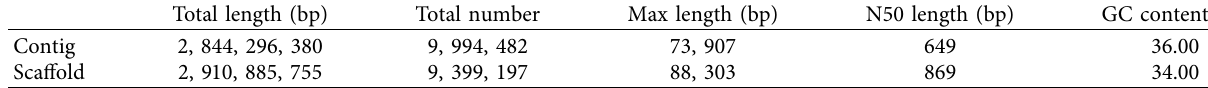
Table 3: Statistics of the assembled CNC genome.